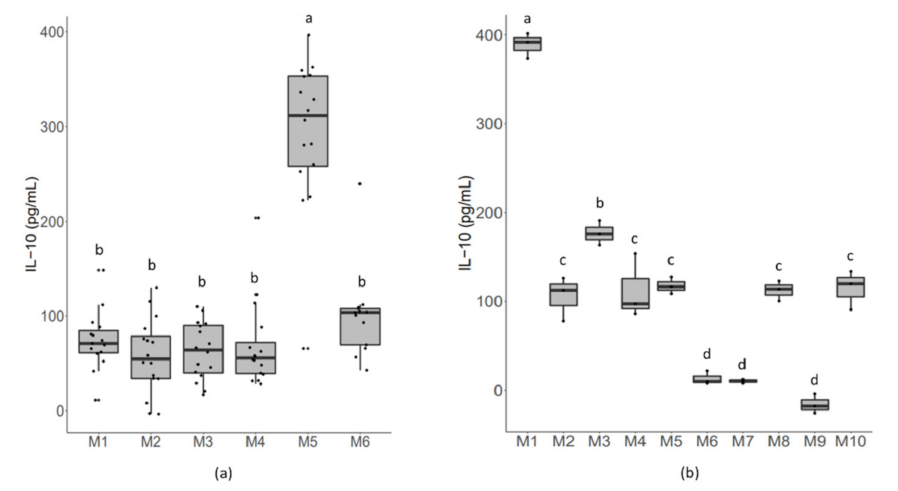
Figure 3. Mouse-dependent responsive strength in the in vitro MLN model. ( a ) Levels of IL-10 in the co-culture supernatant of different B. bifidum strains ( n = 86) and MLN cells isolated from six different C57BL/6J mice. ( b ) Levels of IL-10 in the co-culture supernatant of A. muciniphila AH39 and MLN cells isolated from ten different C57BL/6J mice. Different letters indicate significant differences when tested by Tukey’s HSD. All tests were replicated three